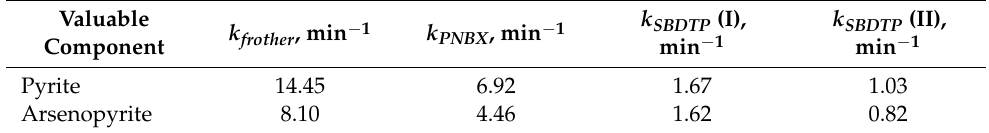
Table 3. Established kinetic constants for